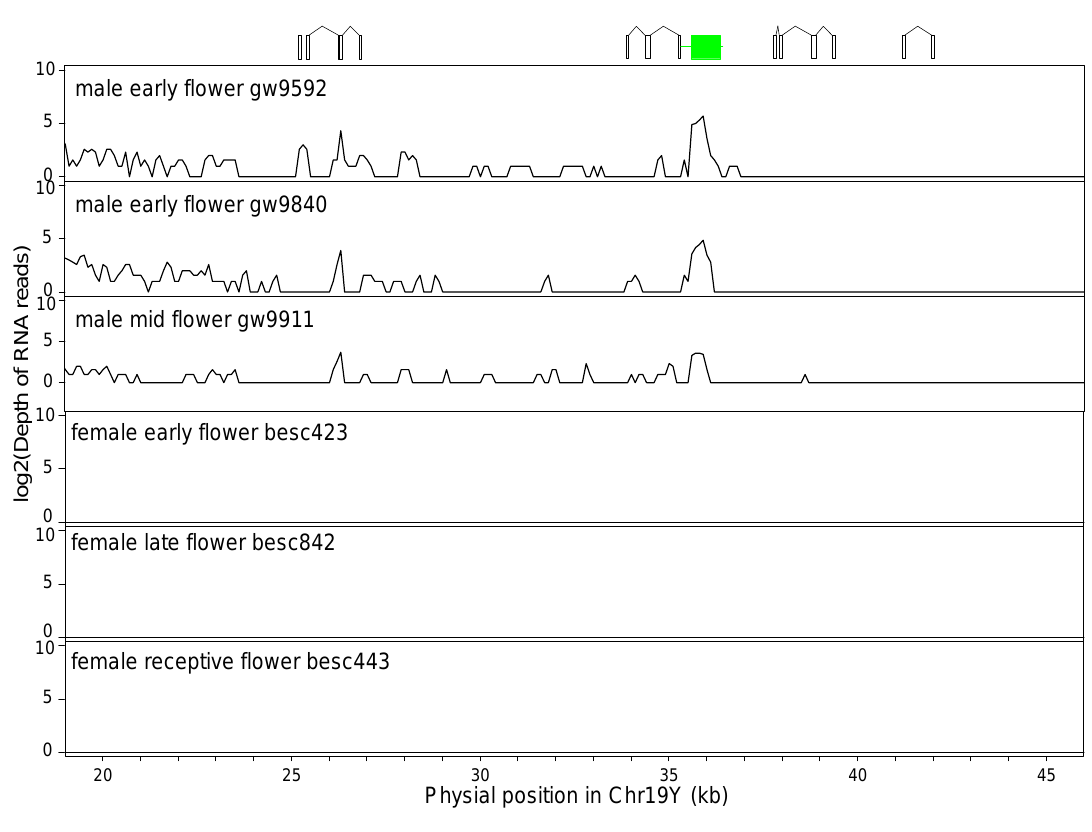
Figure 6. RNA-seq reads depth in the inverted repeats. The expression of fragments of the response regulator gene in the male-specific invert repeats was quantified by logarithmic of counts of RNA-seq reads in three male and three female individuals sampled from different flowering stages. Fragments of gene models are displayed above to help visualization, where the green box is a fragment of HEMA , and open boxes are exons duplicated from the PtRR9 gene.